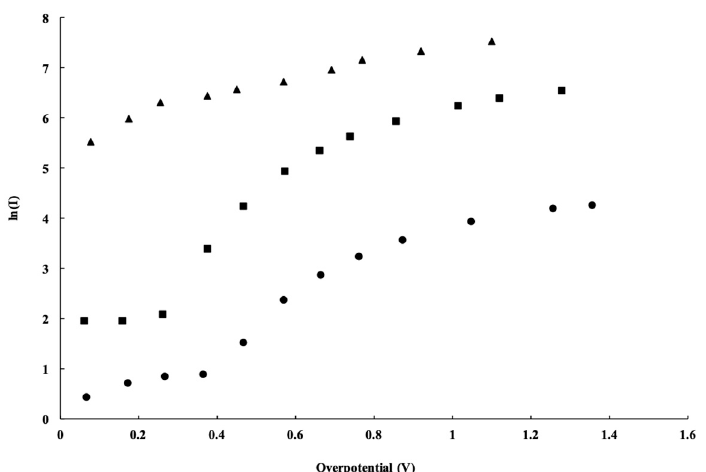
Figure 5. Tafel plot for the custom-built PEM with fully assembled MEA (solid triangle data), a fully detached GDL (solid circular dots), and a repositioned GDL with a Telpro ribbon mesh inserted between the electrocatalyst surface and the GDL (solid square dots).